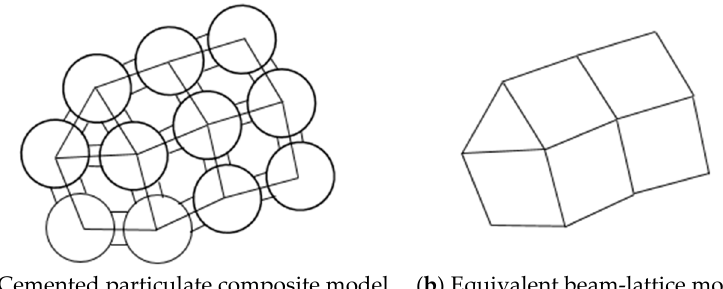
Figure 2. Schematic diagram of equivalent beam network model.